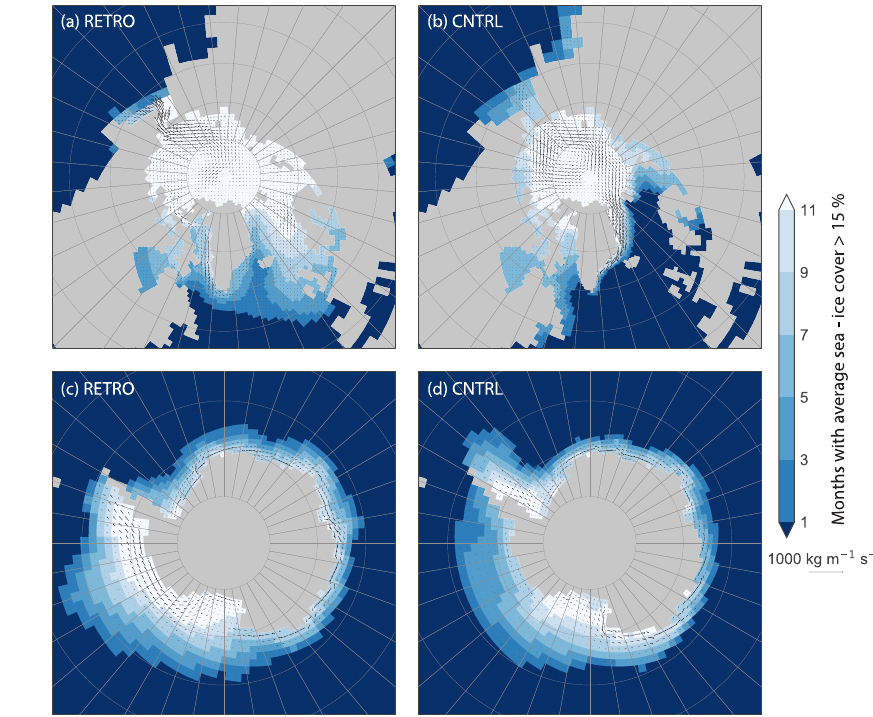
Figure 3. Duration of sea-ice cover in RETRO (a, c) and CNTRL (b, d) . The vectors show annual mean sea-ice transport. For technical reasons, no sea-ice transport is displayed near the North Pole. The seasonal cycle of sea-ice coverage is shown in a video in https://doi.org/